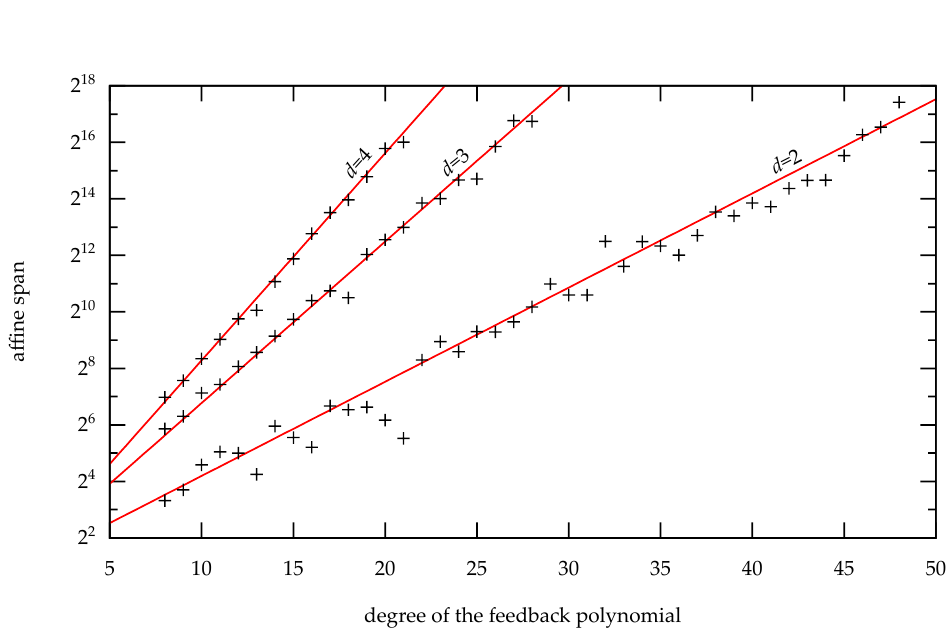
Figure 3: Measured affine span of some primitive pentanomials (marks) vs. estimates